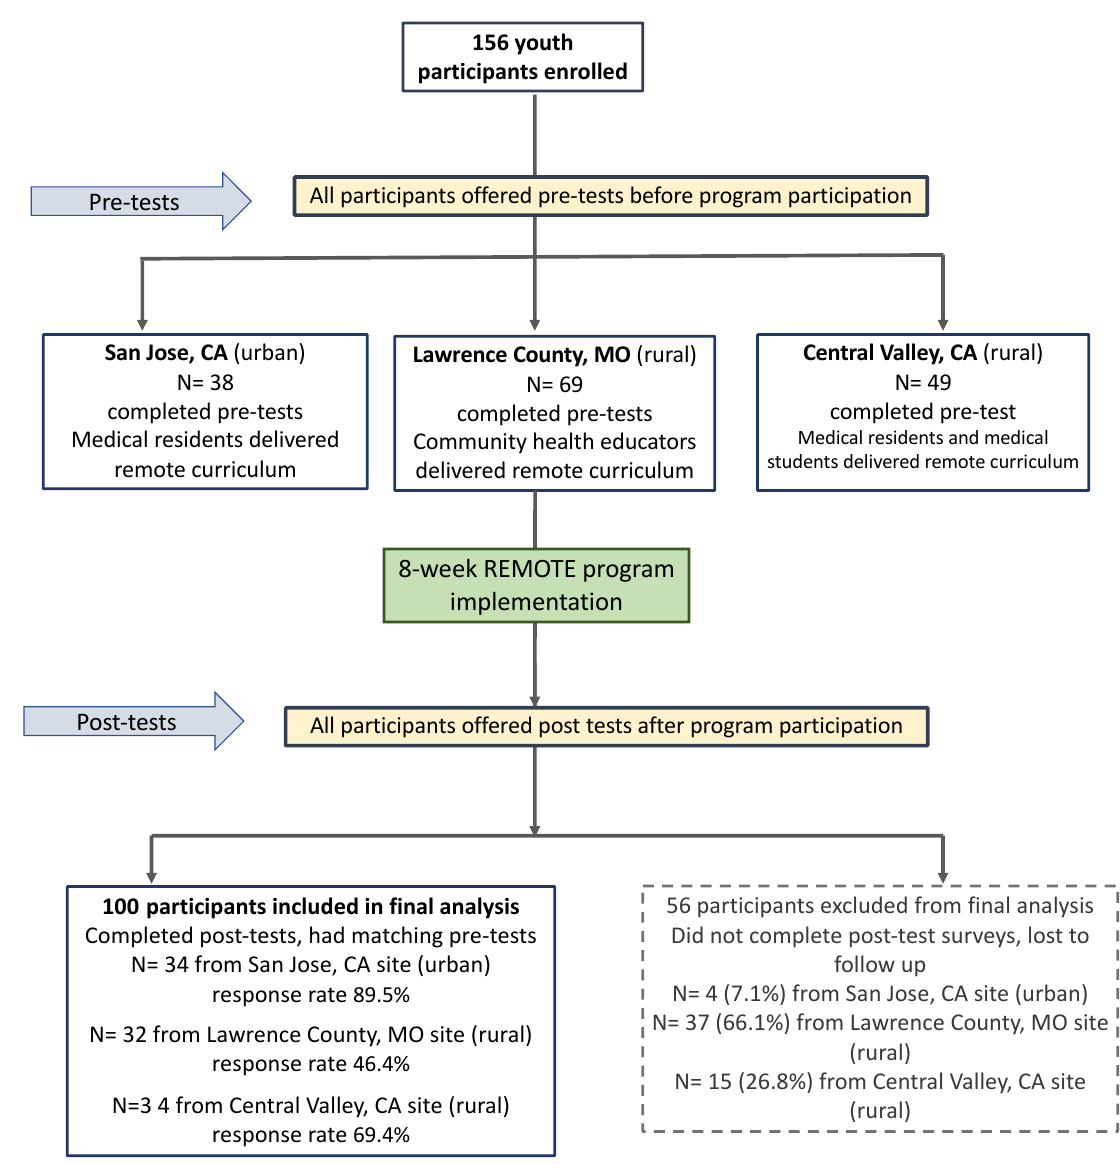
Figure 1. Remote implementation and evaluation of the Stanford Youth Diabetes Coaches Program (SYDPC), a health promotion and coaching skills program, in San Jose, CA; Lawrence County, MO; and Central Valley, CA, 2020 – 21.